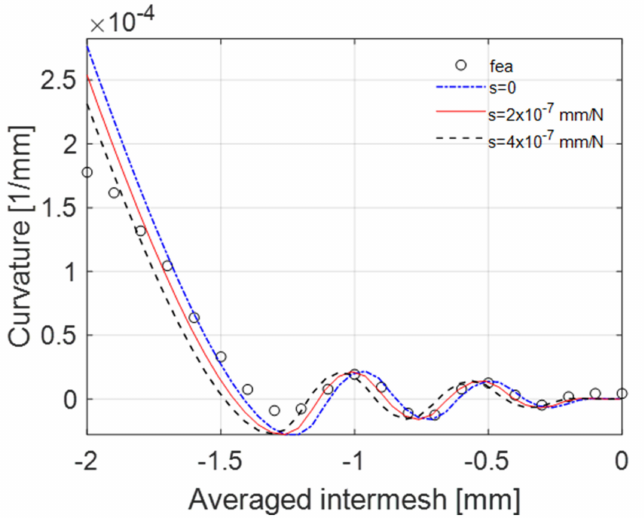
Figure 13. Residual curvature as a function of the averaged